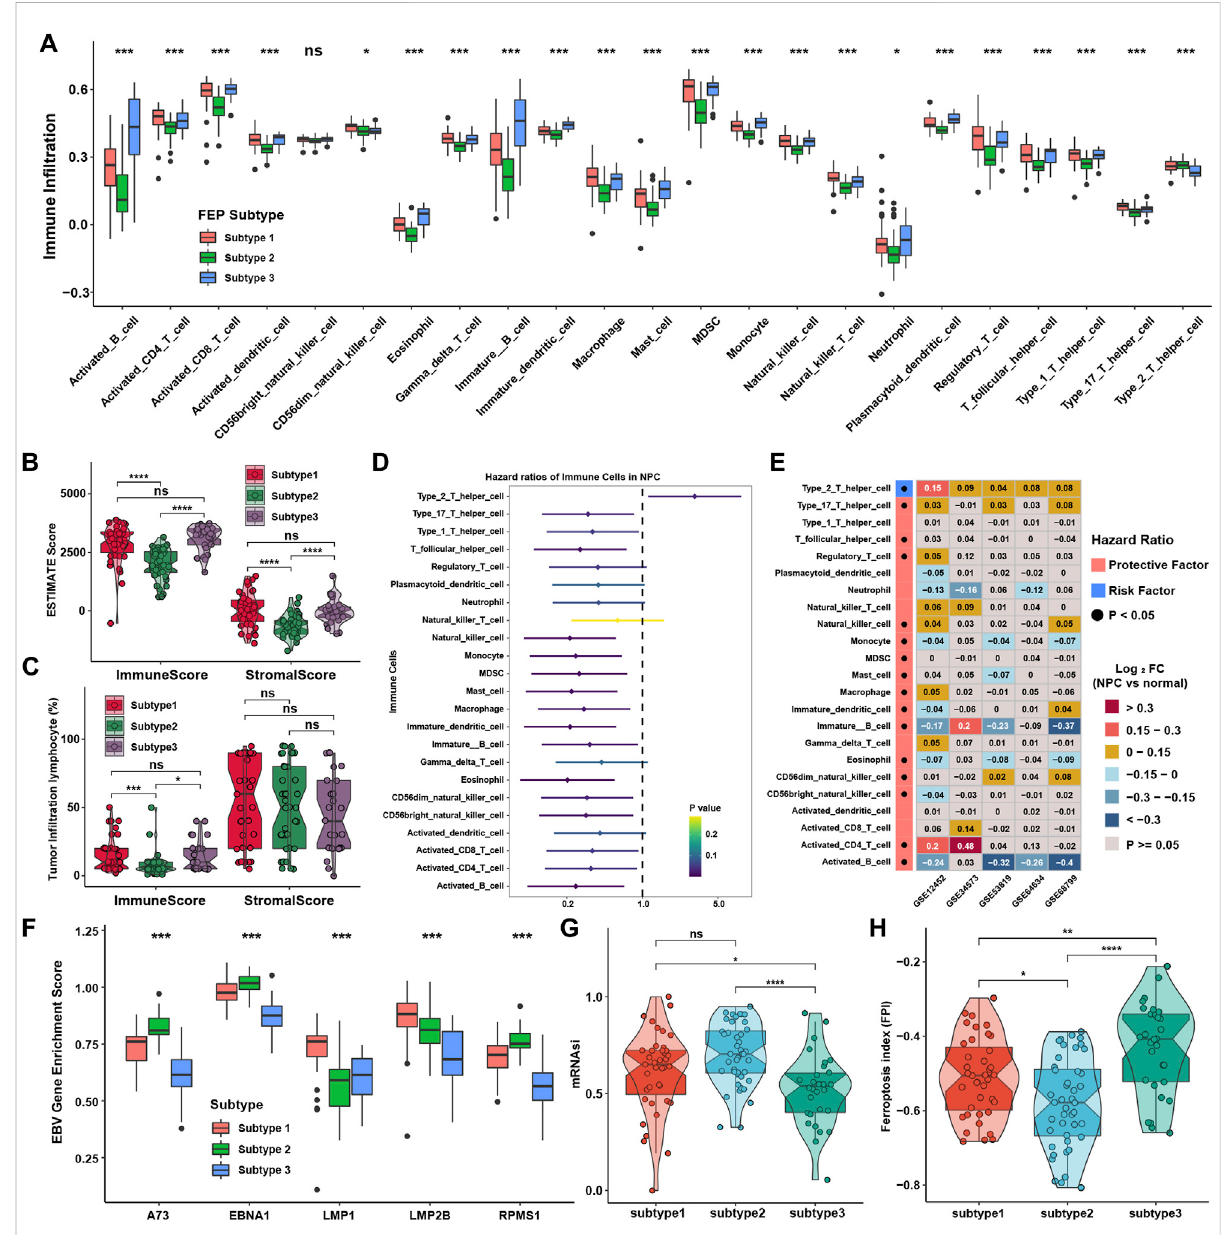
FIGURE 2 Immune cell in fi ltrationcharacteristics indistinctferroptosissubtypes. (A) Immune cell in fi ltrationlevels inTMEamongferroptosissubtypes. (B) Immune and stromal scores via ESTIMATE among ferroptosis subtypes. (C) Intratumor and stromal tumor in fi ltration lymphocytes provided in GSE102349 among ferroptosis subtypes. (D) The prognostic analyses for tumor-in fi ltrating immune cells in TME in GSE102349 cohort, and hazard ratio > 1 and < 1 represented risk and protective factor for survival, respectively. (E) Differential expression analysis of TME in fi ltration in fi ve independent datasets. Black dots in theleftcolumnrepresented p < 0.05. (F) The GSVA enrichmentscore ofEBV genesamongferroptosis subtypes. (G) The mRNAsi among ferroptosis subtypes. (H) FPI among ferroptosis subtypes. The asterisks represented p values (* p < 0.05; ** p < 0.01; *** p < 0.001; **** p < 0.0001) and ns represented no signi fi